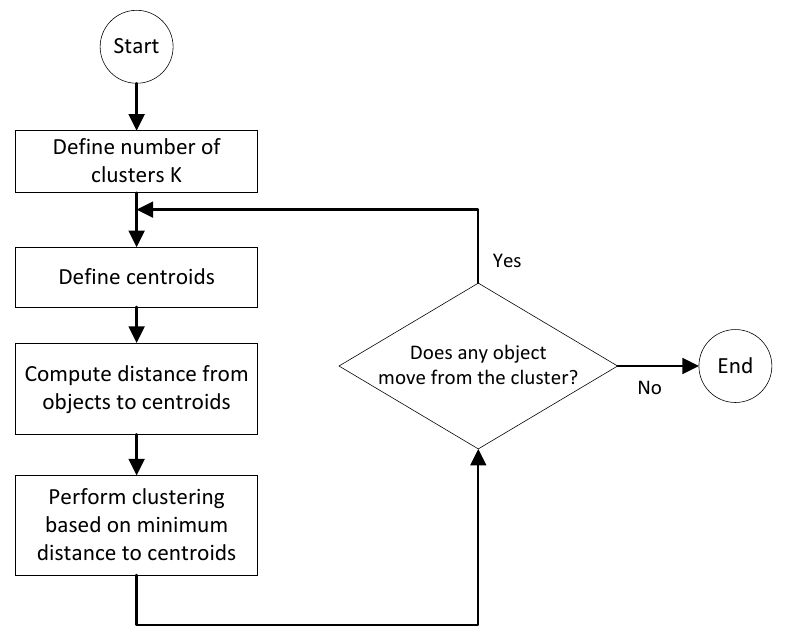
Figure 1. Flowchart of the K-means clustering